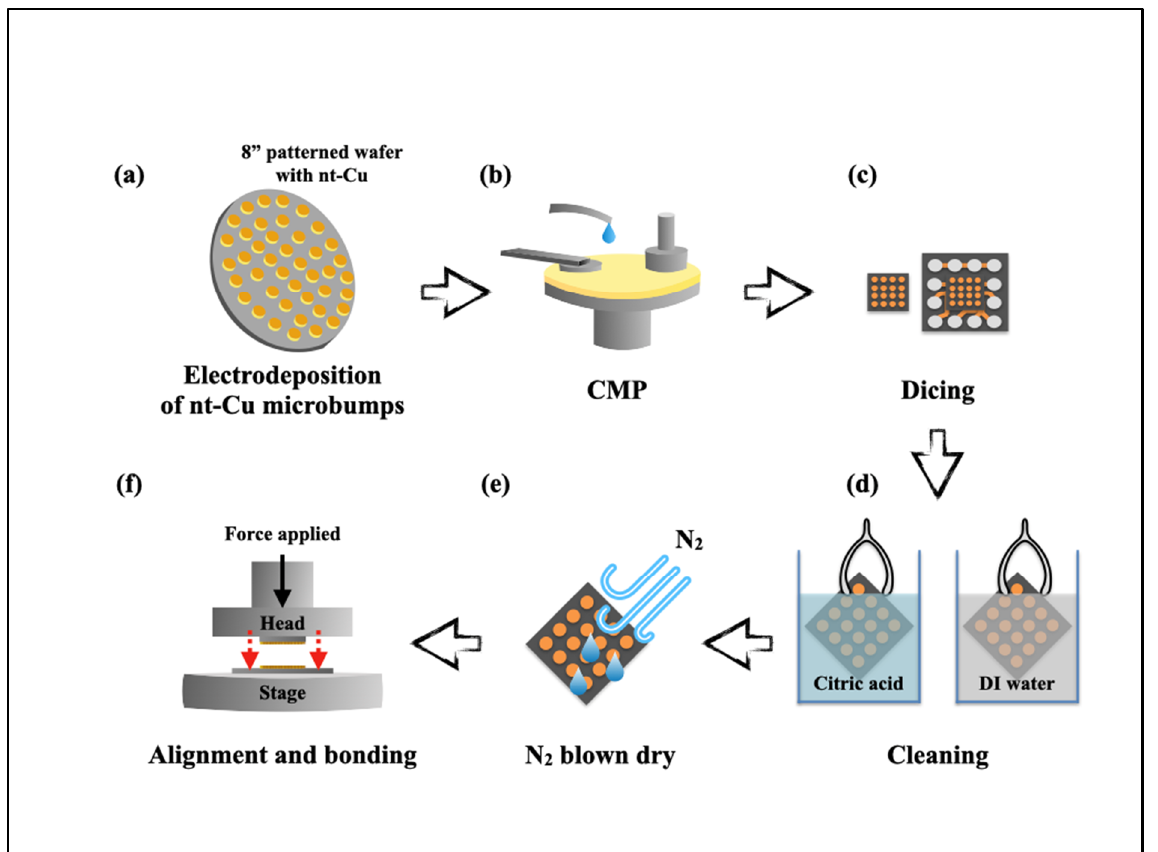
Figure 2. ( a ) Electrodeposition of nt-Cu microbumps by DC current on an 8-inch patterned wafer. The diameter of nt-Cu microbump is 30 µm and the pitch is 80 µm. ( b ) CMP process of 8” patterned wafers. The bump surface roughness ( R q) is below 5 nm. ( c ) Schematic of test vehicles in this study: 6 × 6 mm 2 for top die and 15 × 15 mm 2 for bottom die. ( d ) Before the bonding process, bonding surface was cleaned by citric acid and rinsed by deionized water. ( e ) Each die was then dried with N 2 gas. ( f ) Top die and bottom die were set on the bonding head and stage to align by alignment marks. The first step bonding under 31 MPa, 47 MPa and 93 MPa compression at 300 °C within 10 s was performed in N 2 ambient. Table 2. Bonding conditions of the first step bonding process. Condition